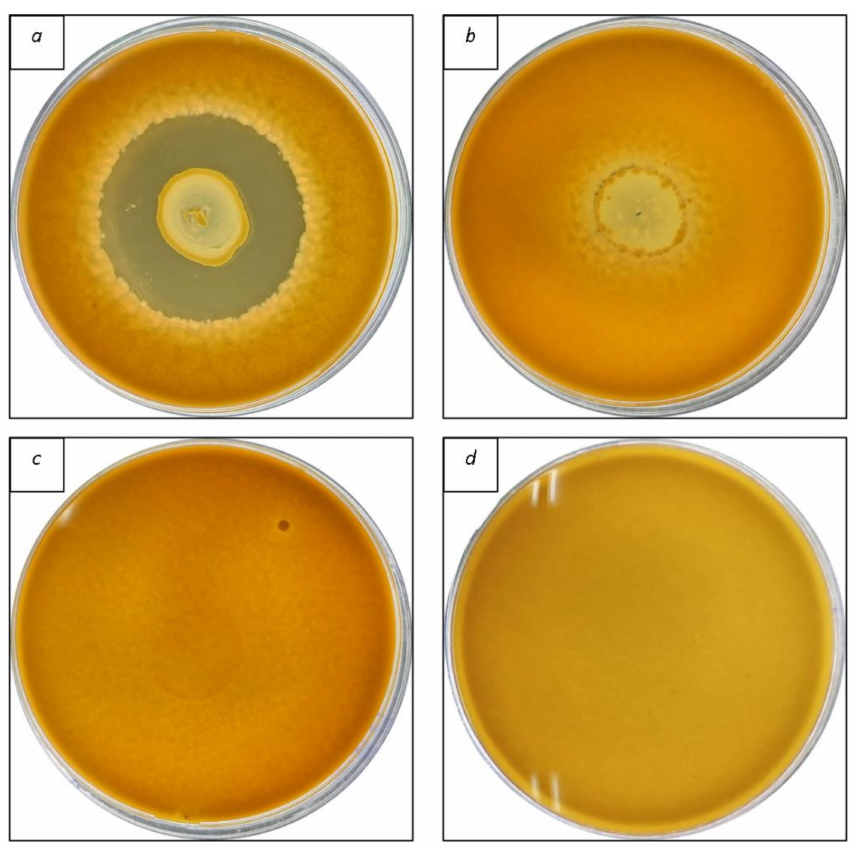
Figure 1. Screening of lactic acid bacteria (LAB) through overlay method. Strong inhibitory action ( a ); slightly inhibitory effect ( b ); no inhibitory action ( c ); control ( d